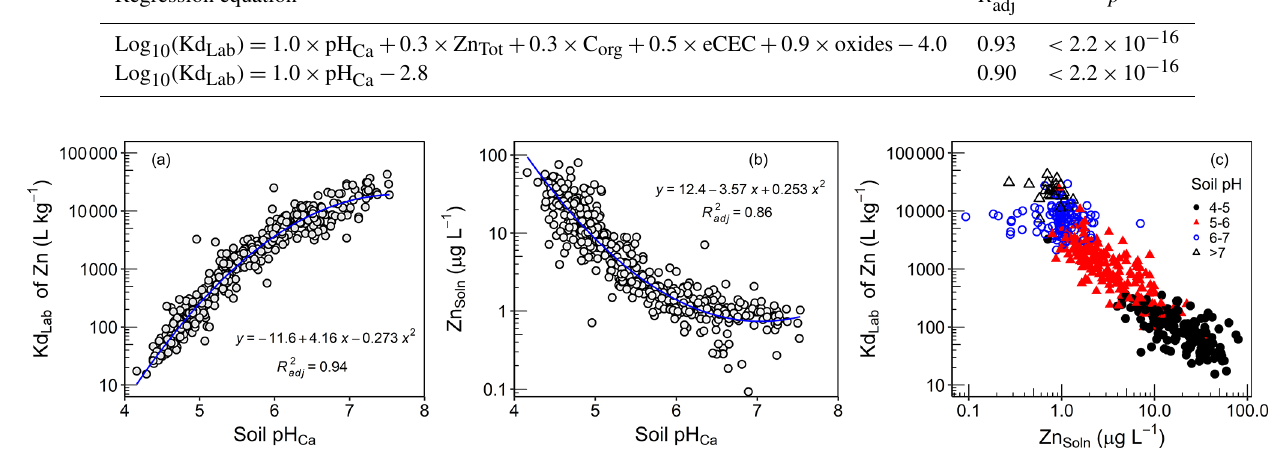
Figure 6. Values of (a) Kd Lab and (b) Zn Soln as a function of soil pH. (c) The relationship between K lab